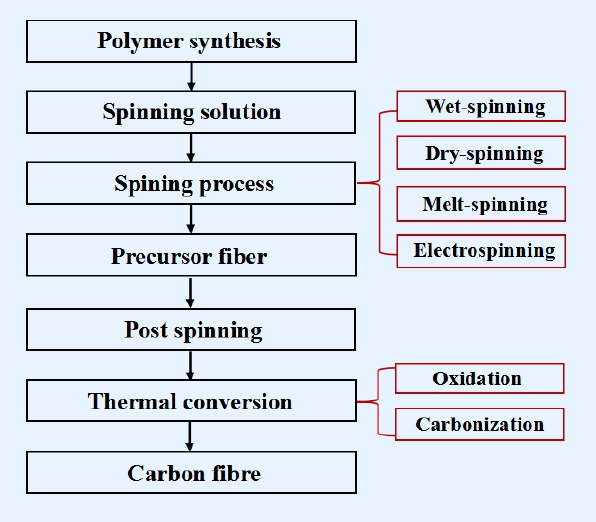
Figure 7. Flow chart of the CF production process.